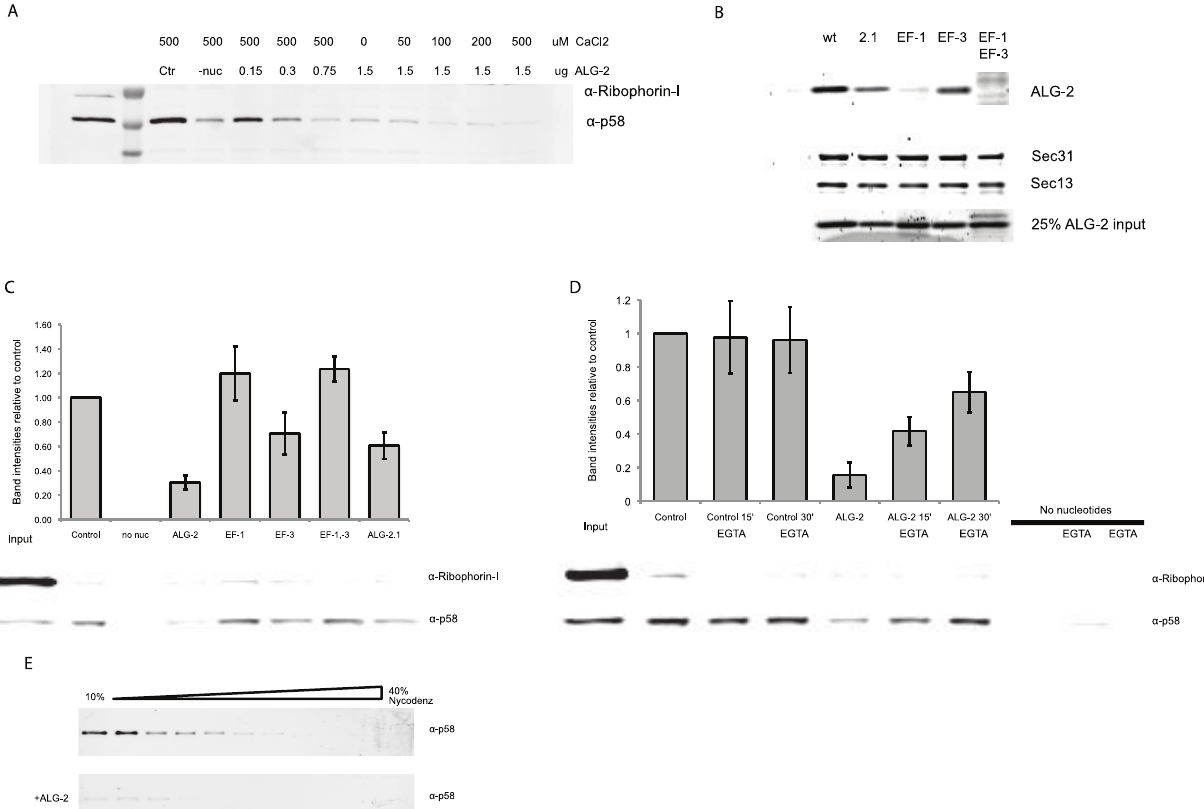
Figure 2. ALG-2 attenuates in vitro reconstituted COPII vesicle budding in a reversible manner. Budding investigated using p58/ERGIC as a marker after incubation of HeLa cell donor membranes with recombinant Sar1A, Sec23A/24D, Sec13/31A and 0–2 ug of recombinant ALG-2. A. Budding efficiency was measured at increasing concentrations of either ALG-2 or Ca 2 + . B. Attenuation of budding was dependent on EF hand 1 of ALG-2. Binding of ALG-2 wildtype (wt) and mutants to Sec31A was tested by incubating either wt ALG-2 (wt), ALG-2.1 (2.1), ALG-2mutEF1 (EF-1), ALG- 2mutEF3 (EF-3) or ALG-2mutEF1&3 (EF-1–3) with Sec31A-coated beads. Eluates were separated by SDS-PAGE and visualized using SyproRed. C. In vitro reconstituted budding using p58 as a budding marker. Mutant versions of ALG-2 were added to the budding reaction in equimolar amounts. D. ALG-2/Ca 2 + budding attenuation was reversed by chelation of Ca 2 + . In vitro reconstituted vesicle budding using p58 as a cargo protein marker. Budding was performed for 45 min in the presence of Ca 2 + only (control), Ca 2 + /ALG-2 (ALG-2) or in absence of nucleotides. EGTA was added to budding reactions at T=15 and T=30 min and reactions were incubated in the presence of 1 mM EGTA for the indicated time periods (min). Background budding levels were found by omitting nucleotides (no nuc). SEM of three independent experiments. E. 10–40% Nycodenz gradient was layered on top of the product of the budding reactions performed in the absence (upper panel) or presence (lower panel) of recombinant ALG-2.